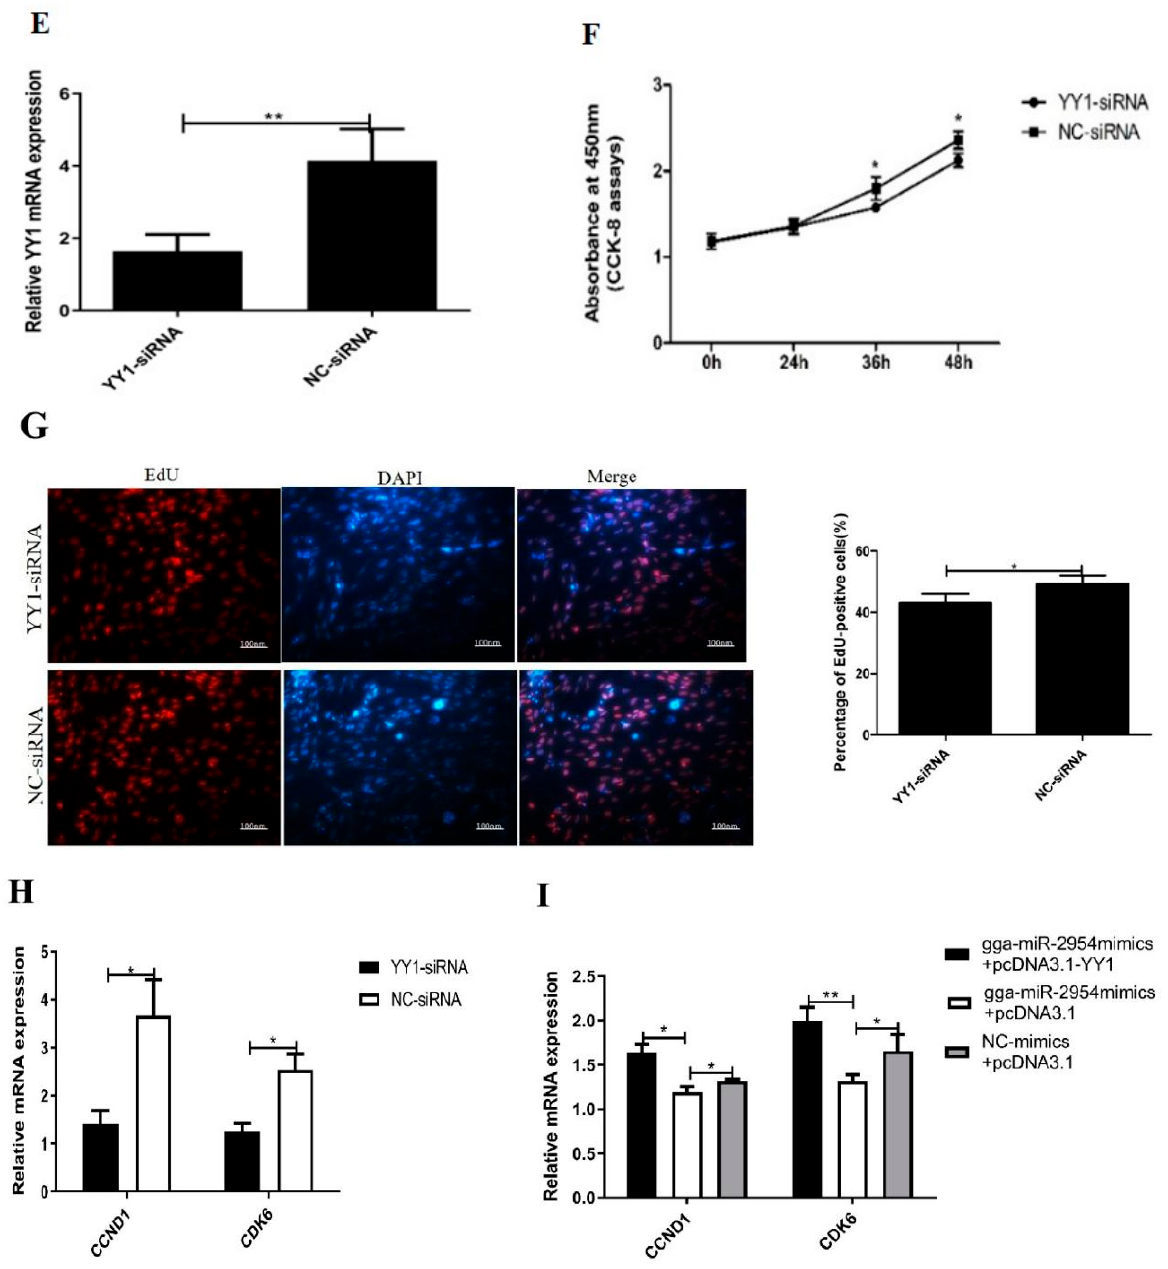
Figure 6. Gga-miR-2954 inhibits myogenic proliferation through targeting YY1 . ( A ) The mRNA expression of YY1 after pcDNA3.1-YY1 transfection. ( B )The results of cell proliferation test of CCK-8 after YY1 overexpression. ( C ) The results of EdU cell viability test for YY1 overexpression. Scale bar = 100 μ m. ( D ) The mRNA expression of CCND1 and CDK6 after YY1 overexpression. ( E )The mRNA expression of YY1 afterYY1-siRNA transfection. ( F )The results of cell proliferation test of CCK-8 afterYY1-siRNA transfection. ( G ) The results of EdU cell viability test for YY1 inhibition. ( H ) The mRNA expression of CCND1 and CDK6 after YY1-siRNA transfection. ( I )The mRNA expression of CCND1 and CDK6 after gga-miR-2954 and pcDNA3.1 ‐ YY1 transfection. Data represent the mean ± SEM from at least three independent experiments (* P < 0.05; ** P < 0.01).